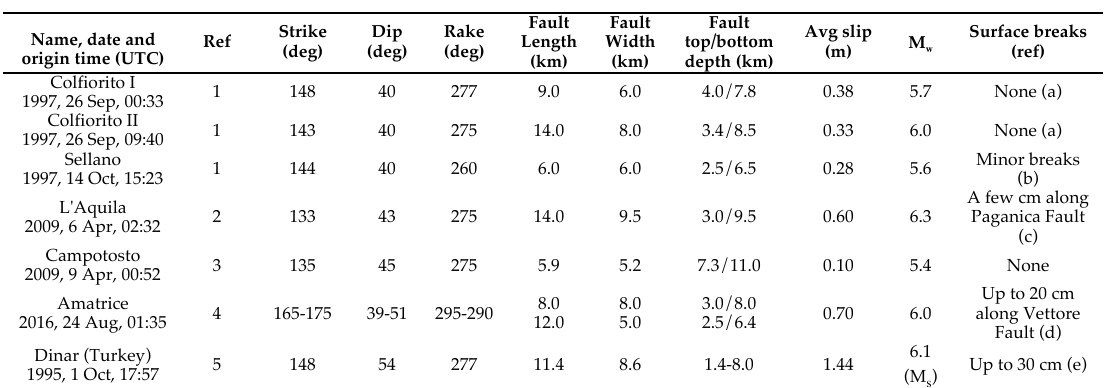
Table 1 . Fault parameters for the 1997, 2009 and 2016 central Apennines earthquakes, and for the 1995 Dinar, southern Turkey earthquake: (1) DISS Working Group [2015]; (2) Vannoli et al. [2012]; (3) this work; (4) Gruppo